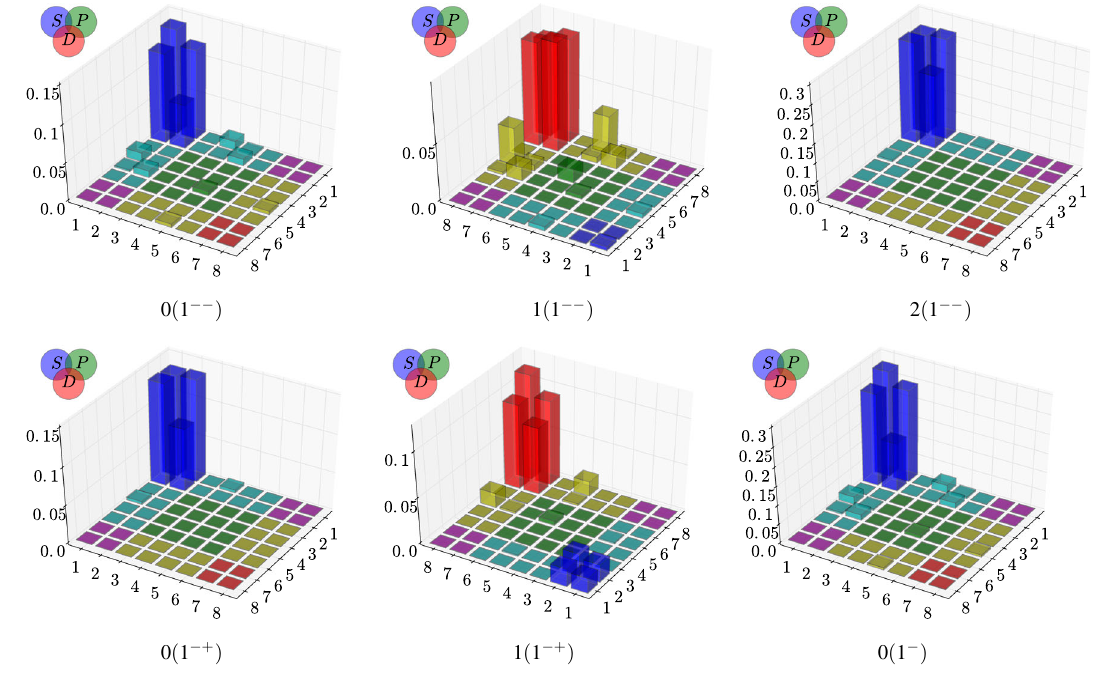
Fig. 8 Orbital angular momentum decomposition of vector mesons. Axes and colors as in Fig. 7 Table 3 Orbital angular momentum content of ground and excited vector